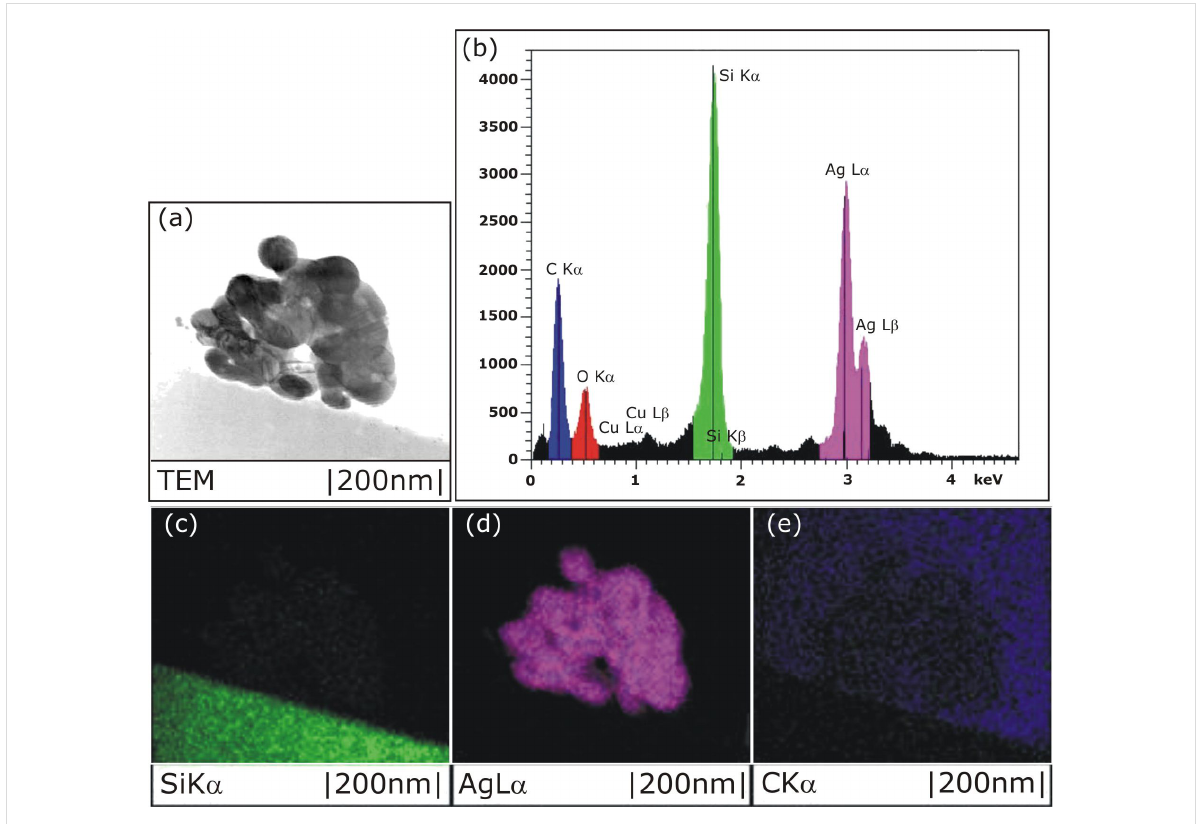
Figure 6: TEM cross section image of a silver nanoparticle on a glass substrate (a), an EDX spectrum recorded across the cross section (b), and mappings of the elements silicon (c), silver (d), or carbon (e), respectively.